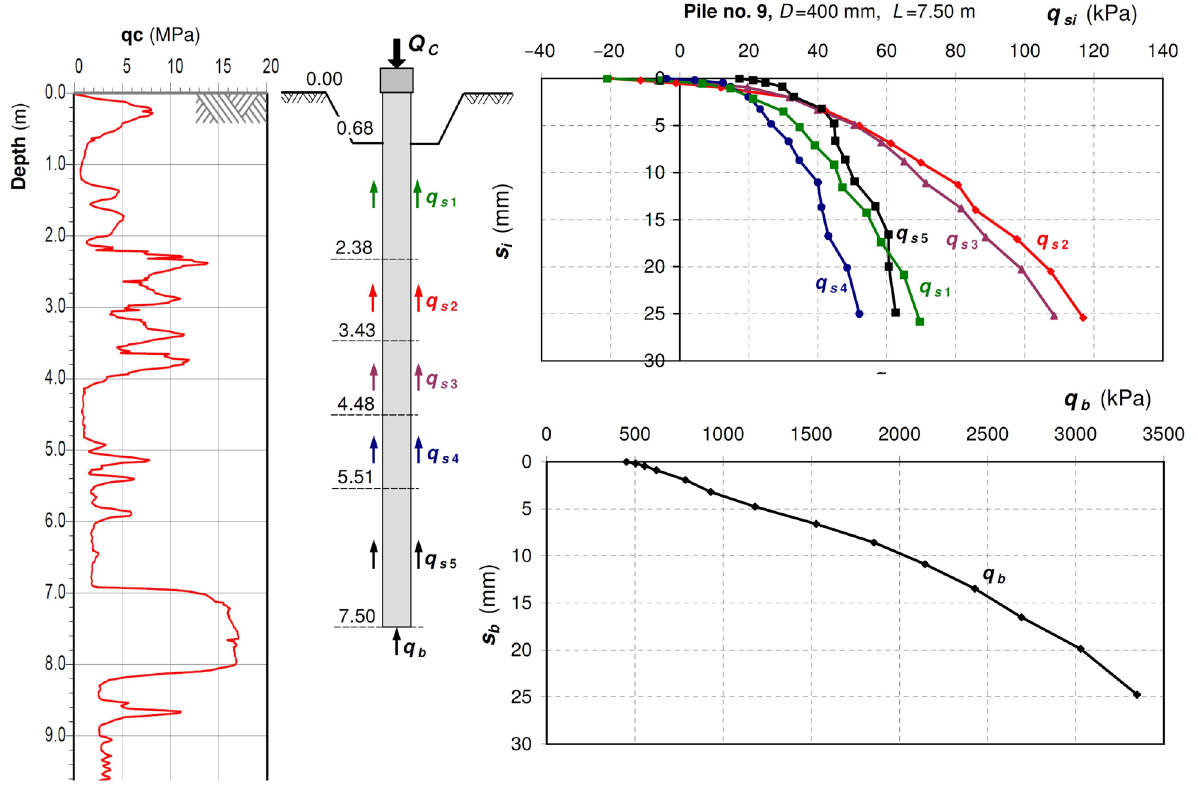
and q unit soil resistances around the pile after taking the residual force into s b